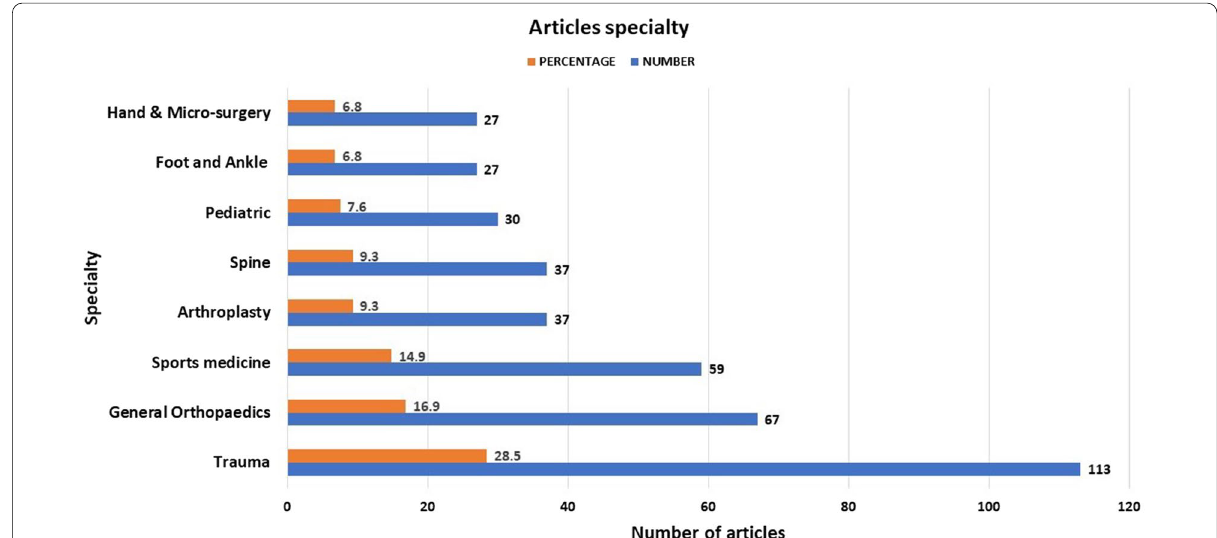
Fig. 3 Distribution of articles according to the